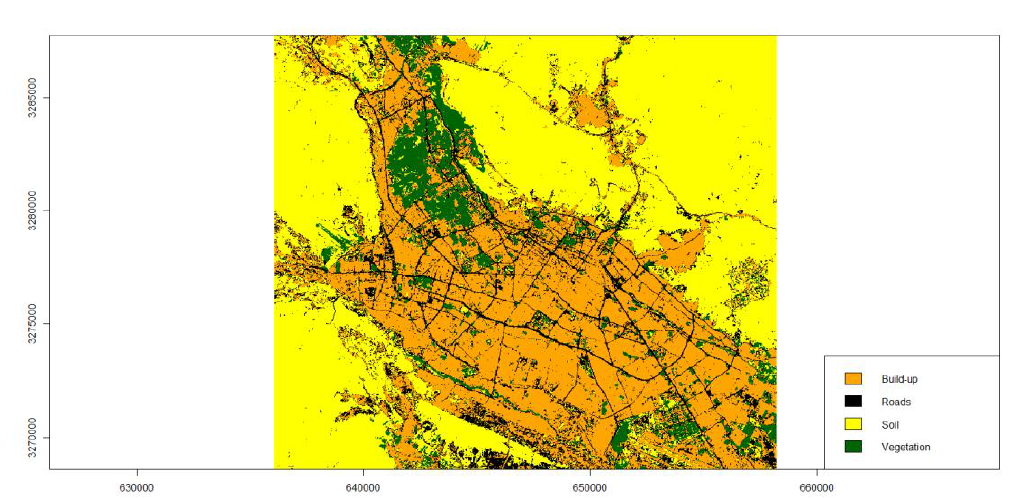
Figure 6. Image classification using a combination of SVM, ML and RF classification techniques within R programming language.